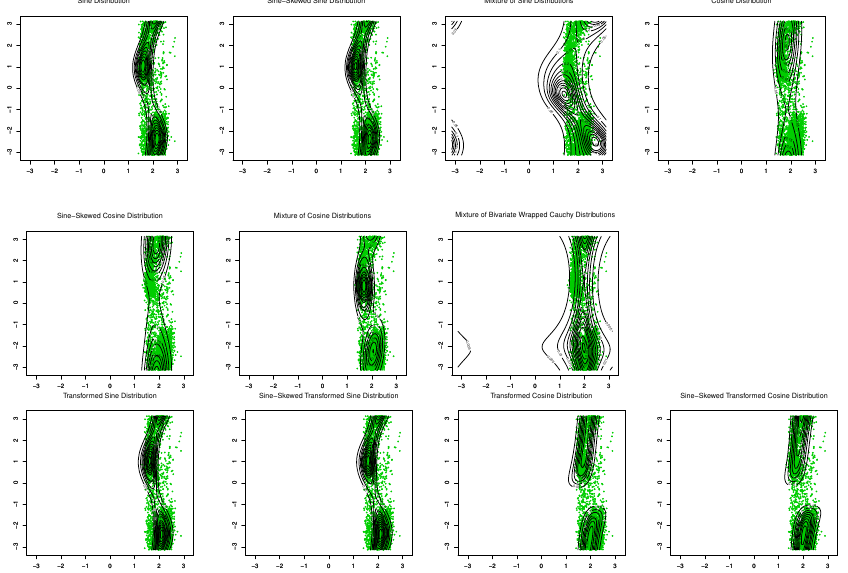
Figure 10. Contour plots of fitted pdfs together with scatter plot for SCOP.3 ( n = 4607). The last row includes the proposed